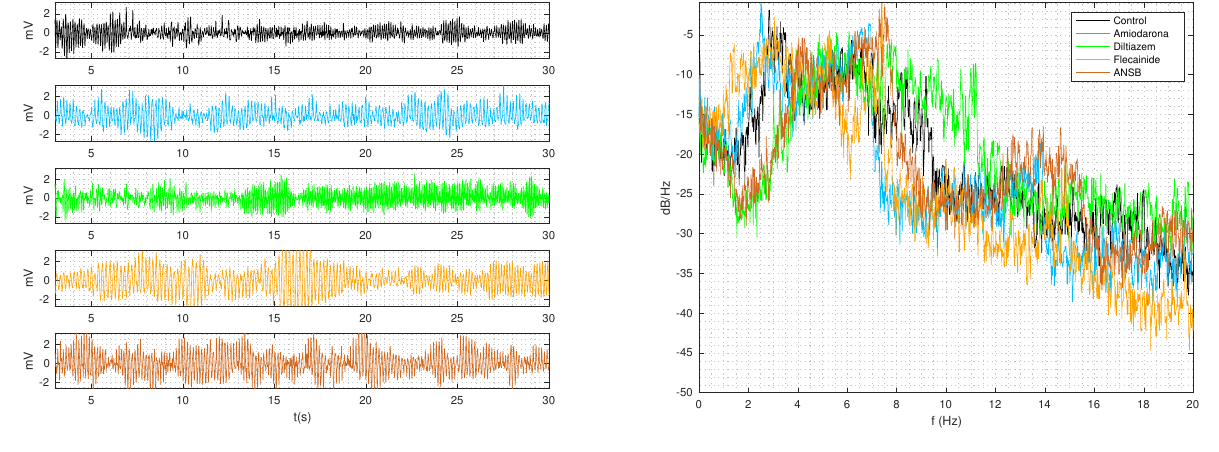
Figure 1. VF in response to various drugs and procedures in the time domain ( left ) and frequency domain ( right )